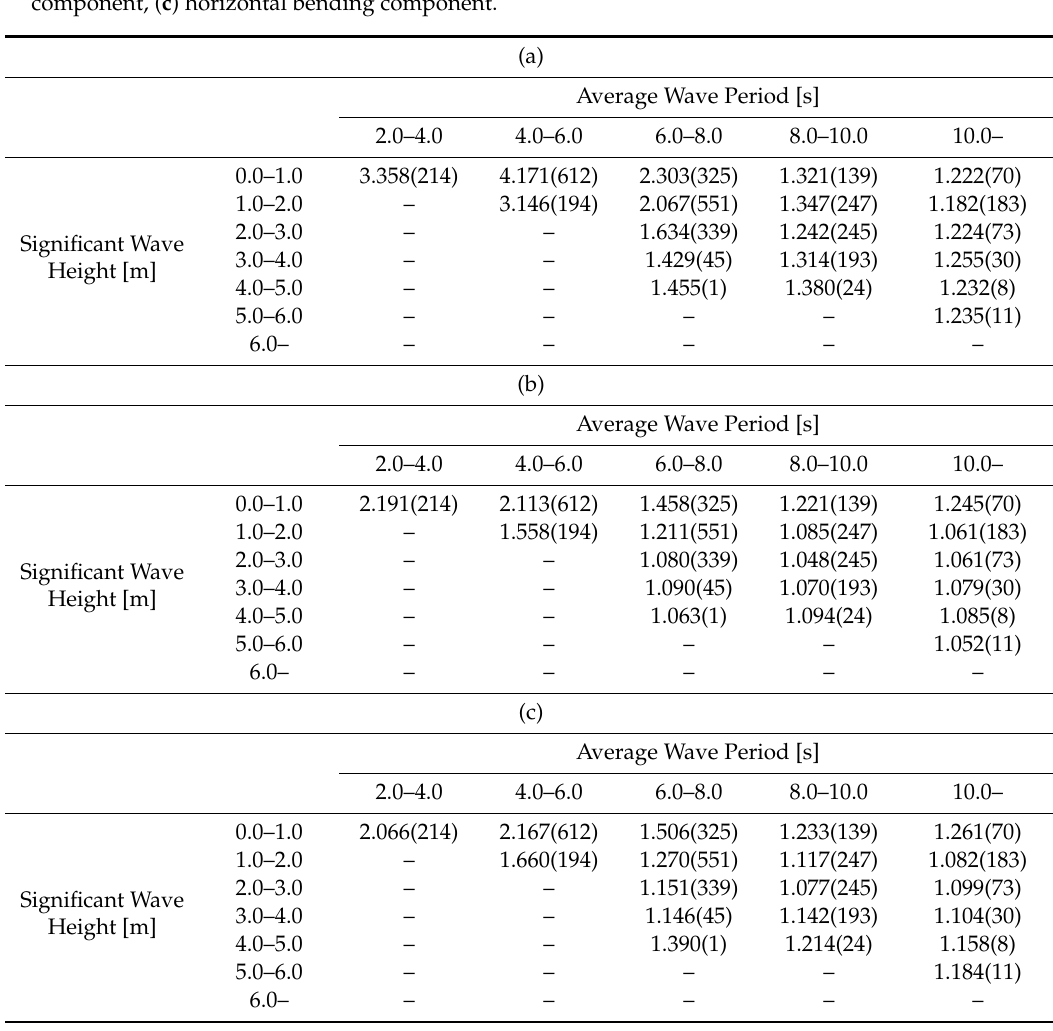
Table 3. Statistics table of whipping factor in head sea, ( a ) vertical bending component, ( b ) torsional component, ( c ) horizontal bending